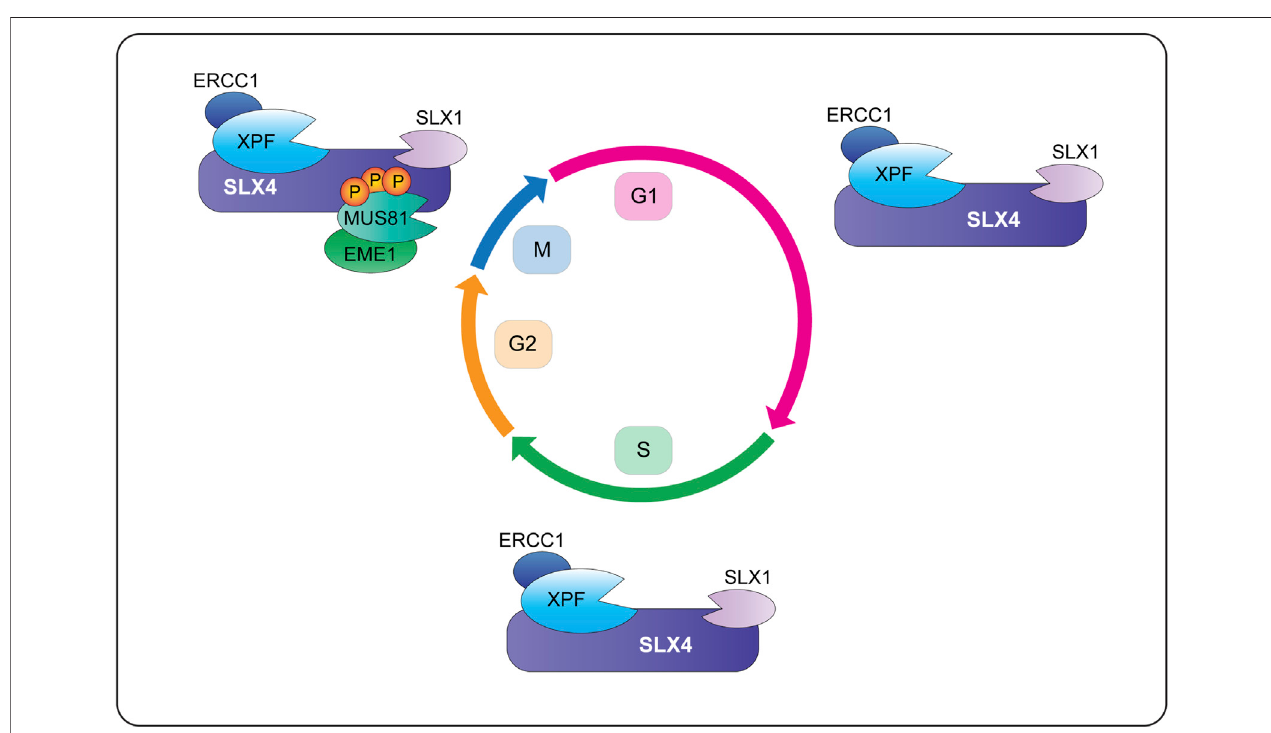
FIGURE 6 | Temporal regulation of SLX4-nuclease complexes in human cells. During G1 and S-phase, SLX1-SLX4 is bound to XPF-ERCC1 and forms a di- nucleasecomplexcalled SX(for thecatalytic subunitsSLX1 and XPF). Cellsalso containpools ofXPF-ERCC1 and MUS81-EME1thatarenot bound toSLX1-SLX4(not shown). When cells enter mitosis, CDK1 phosphorylates SLX4 and CK2 phosphorylates MUS81. These phosphorylation events promote the recruitment of MUS81- EME1 onto the SLX4 scaffold, leading to the formation of a tri-nuclease complex called SMX (for the catalytic subunits SLX1, MUS81 and XPF). More work is needed to determine whether mitotic cells contain SX and SMX complexes or pools of XPF-ERCC1 and MUS81-EME1 that are not bound to SLX1-SLX4 (not shown). Abbreviations: G1, gap 1; S, DNA synthesis; G2, gap 2; M, mitosis; P,